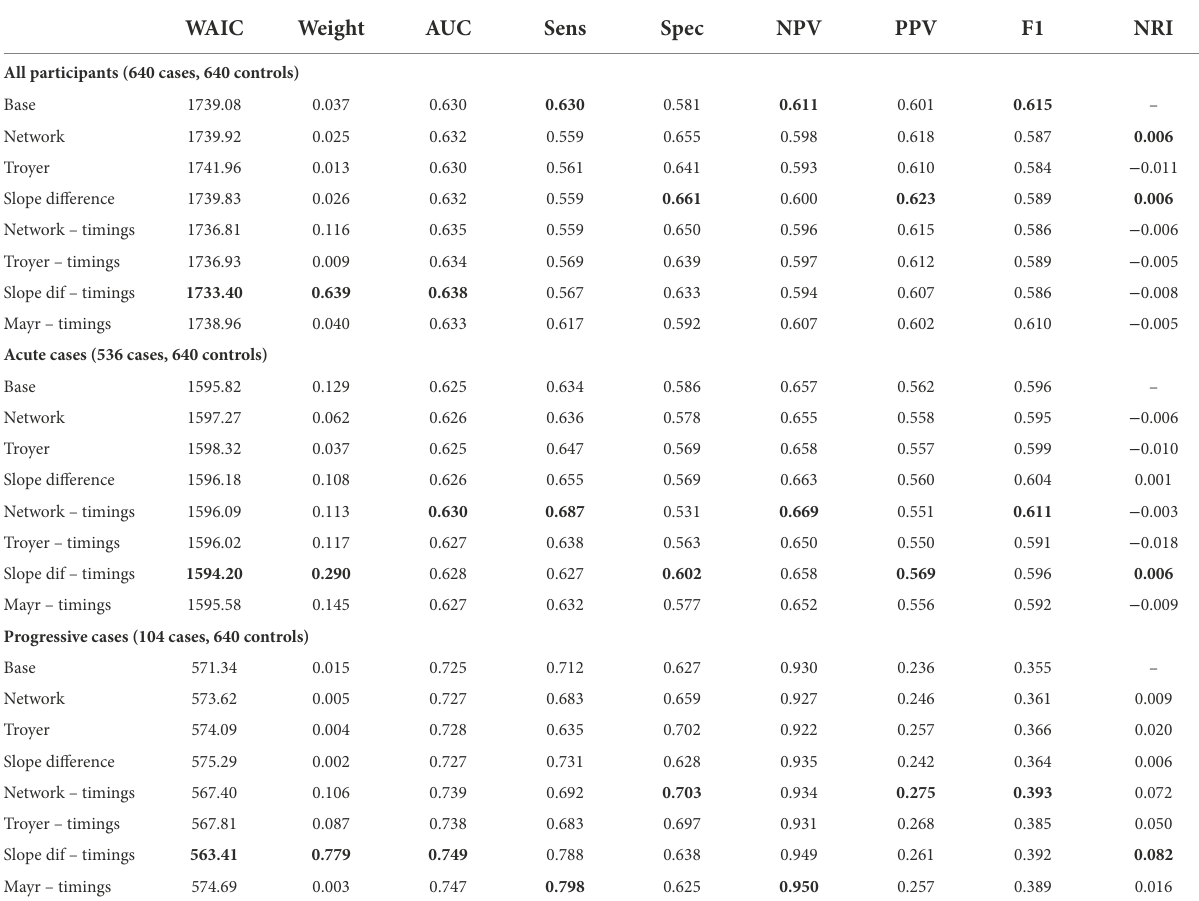
TABLE 3 Performance of models fit with animal fluency data.